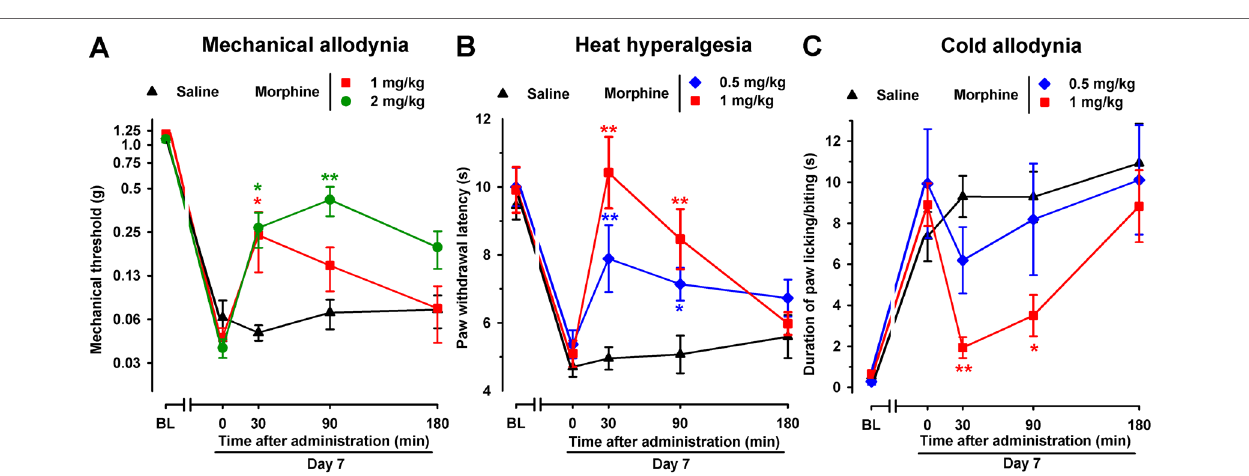
FIGURE 8 | Time course of the effects of a single s.c. injection of morphine (0.5–2 mg/kg) or saline on mechanical allodynia (A) , heat hyperalgesia (B) , and cold allodynia (C) in female WT mice with SNI 7 days after surgery. The von Frey threshold (A), latency to hind paw withdrawal in the Hargreaves test (B) , and duration of hind paw licking or biting in the acetone test (C) were recorded 1 day before (baseline, BL) and 7 days (day 7) after surgery in the paw ipsilateral to the surgery. On day 7 the responses to test stimuli were recorded immediately before (time 0) and at several times (30, 90, and 180 min) after injection of the drug or saline. Each point and vertical line represent the mean ± SEM of the values obtained in 8–13 animals. Statistically significant differences between morphine- and saline-treated groups at the same time after treatment: * P < 0.05; ** P < 0.01 (two-way repeated-measures ANOVA followed by Bonferroni